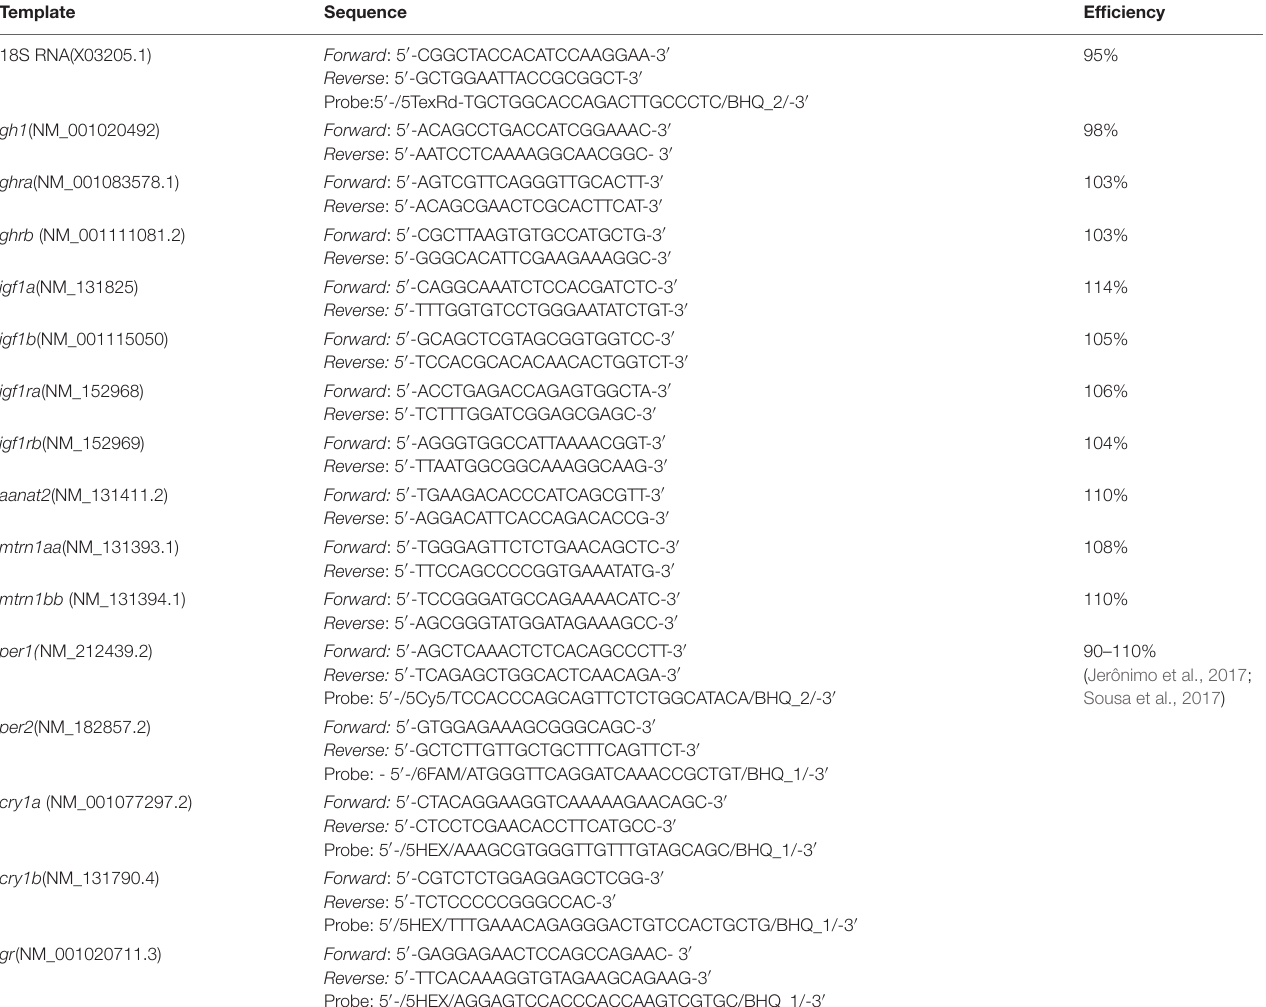
TABLE 1 | Primers, probes, and access numbers for the qPCR assays. Template Sequence